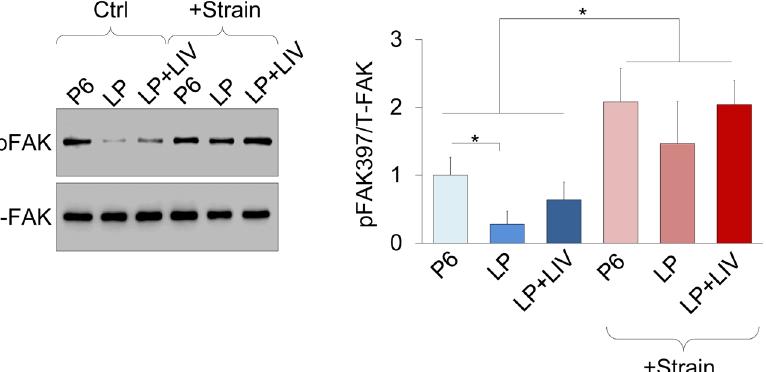
Figure 8. Mechanical activation of focal adhesion kinase was not altered by prolonged culture or LIV. MSCs were subjected to 2% equibiaxial strain at a rate of 0.2 Hz for 20 minutes and probed for Focal adhesion Kinase phosphorylation on Tyr397residue (pFAK). pFAK levels showed an 87% decrease (p < 0.05) in the LP group while LIV treated LP + LIV MSCs had a 300% increase in pFAK levels compared to the LP group. Upon strain application all three groups significantly increased pFAK levels compared to unstrained controls (p < 0.05) but were not statistically different from each other. n = 3/grp, group comparisons were made using one-way ANOVA followed by a Newman-Keuls post-hoc test. p < 0.05, ** p < 0.01, *** p < 0.001, against control and each other. Full-length blots are presented in Supplementary